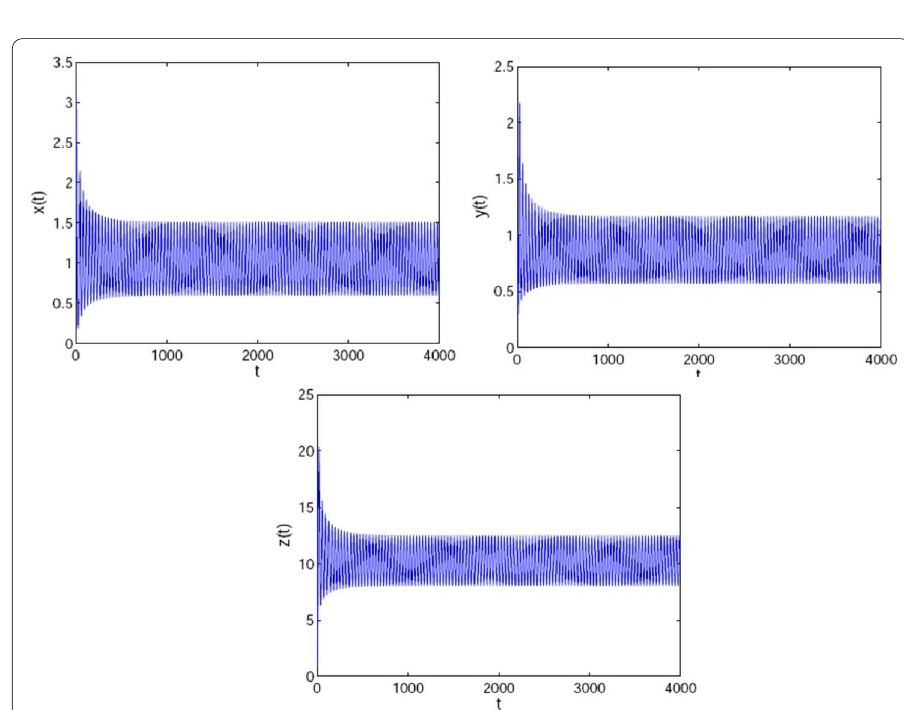
Figure 7 A Hopf bifurcation occurs when τ = 6.5 > τ 0 = 6.153, which means that system (32) is